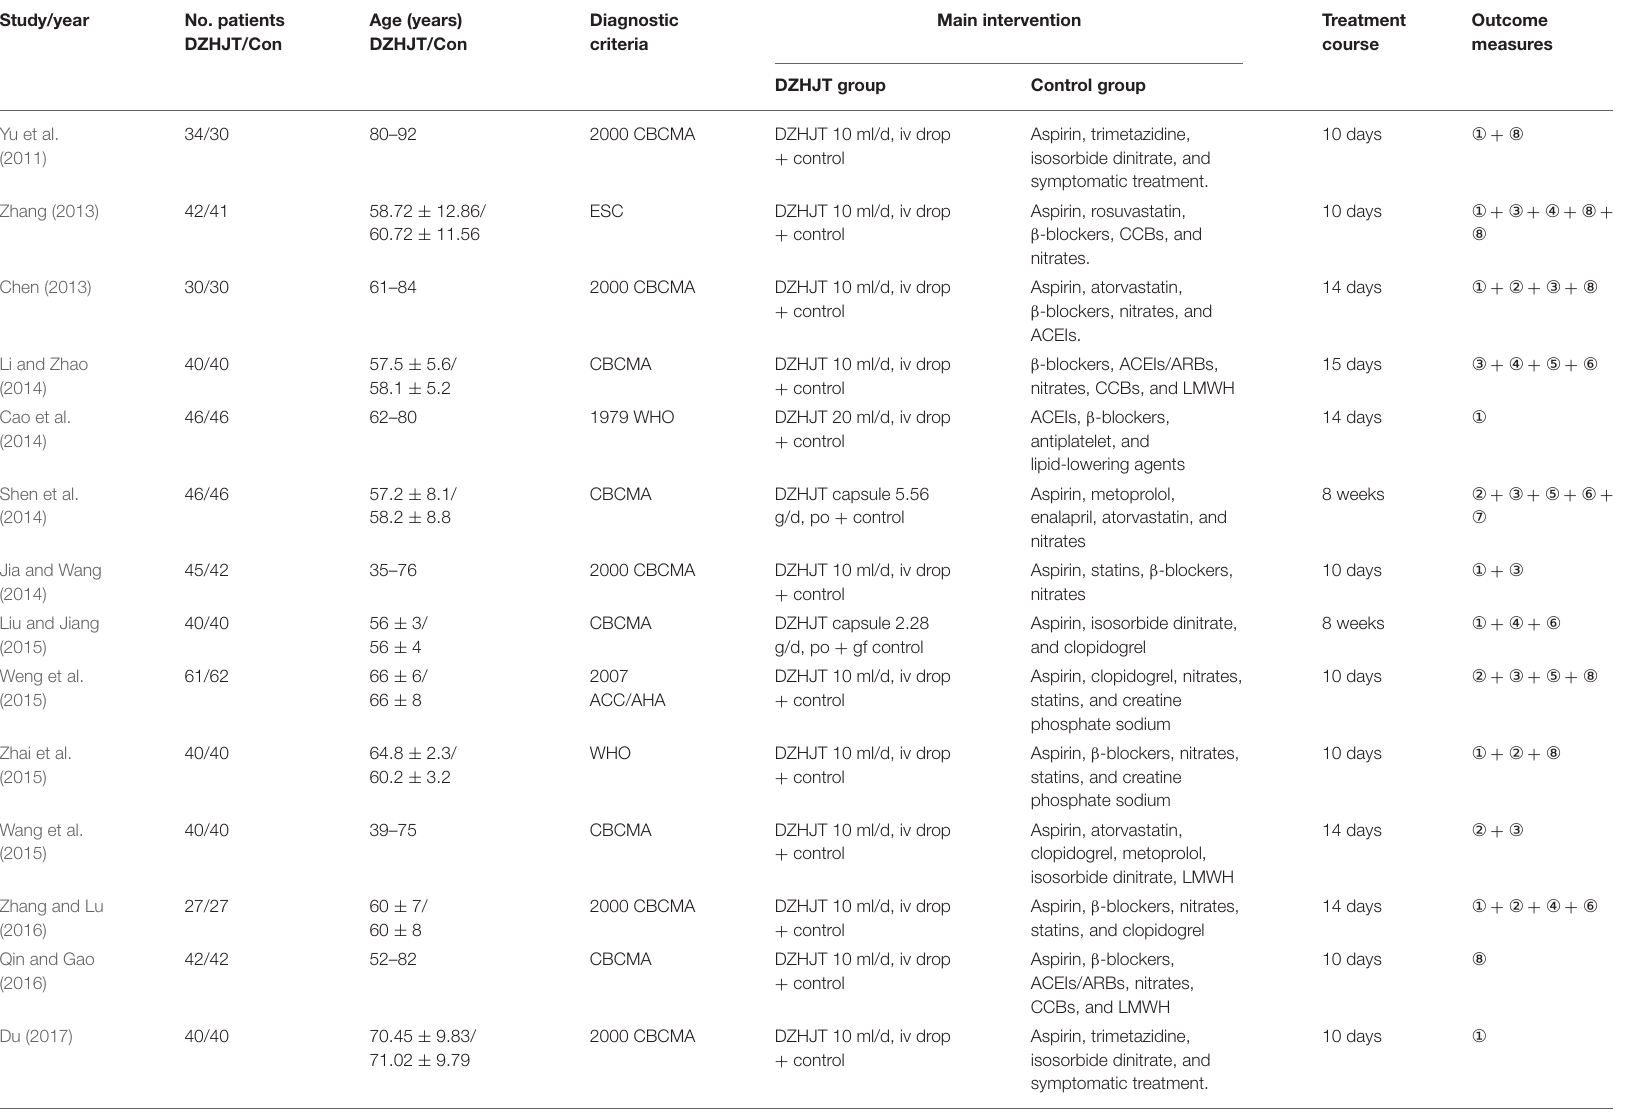
TABLE 1 | Baseline characteristics of the included